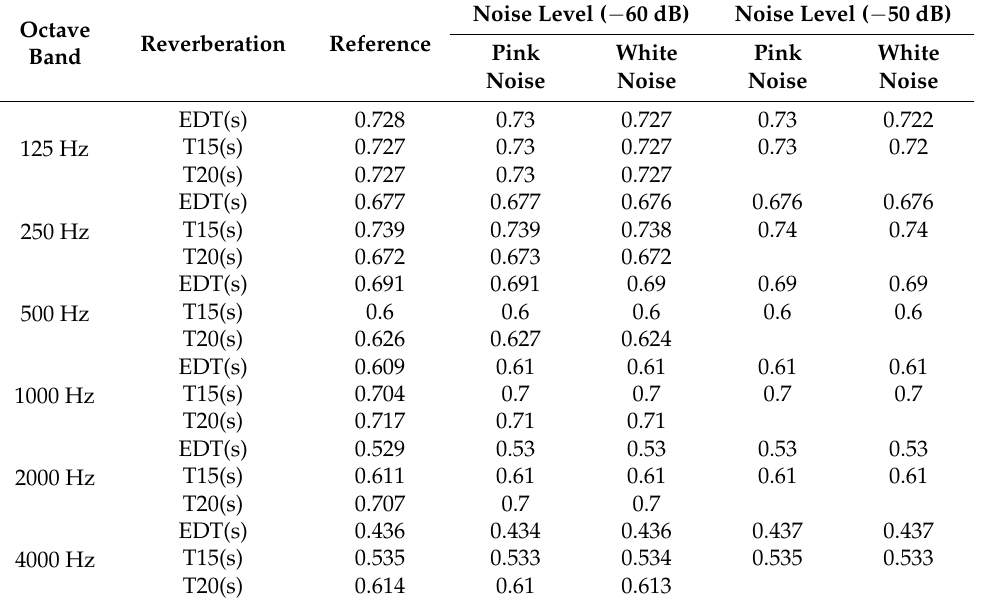
Table 2. Comparison of RTs and EDT between the de-noised RIRs and the reference